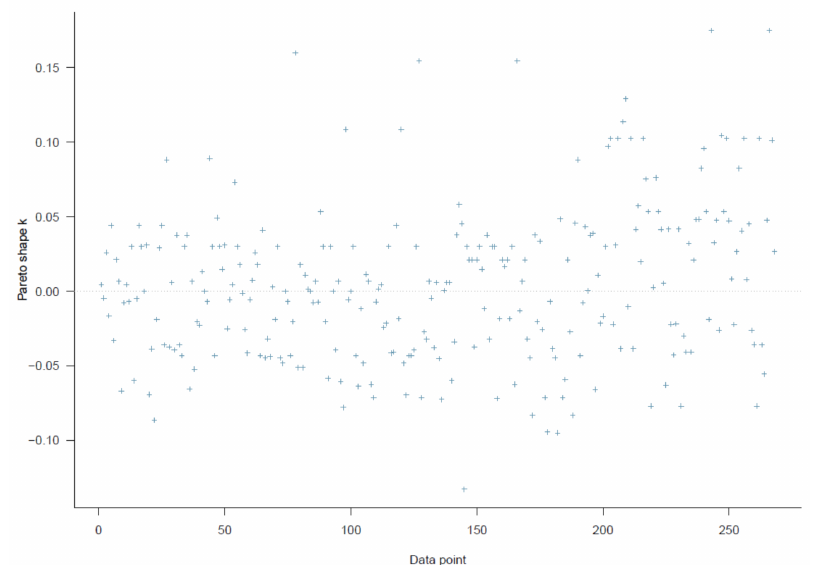
Figure 12. Model 3 (cid:48) s PSIS diagnostic plot.